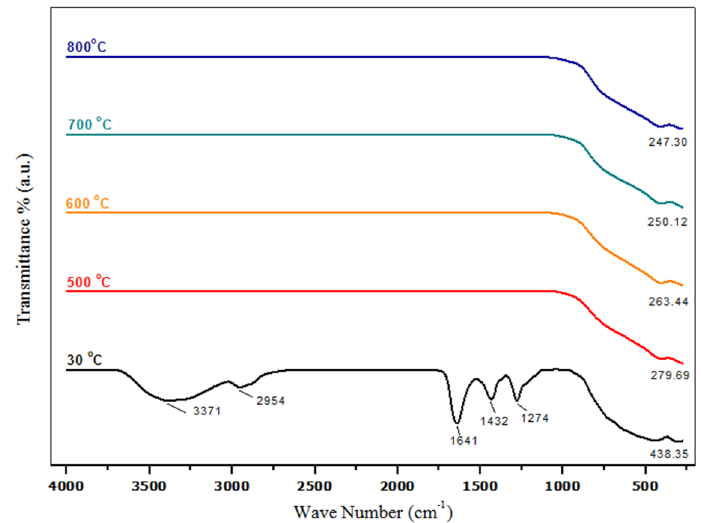
Figure 2. Infrared (IR) spectra of PVP and titanium dioxide (TiO 2 ) nanoparticles before and after calcination with different temperatures in the range of 280–4500 cm − 1 .